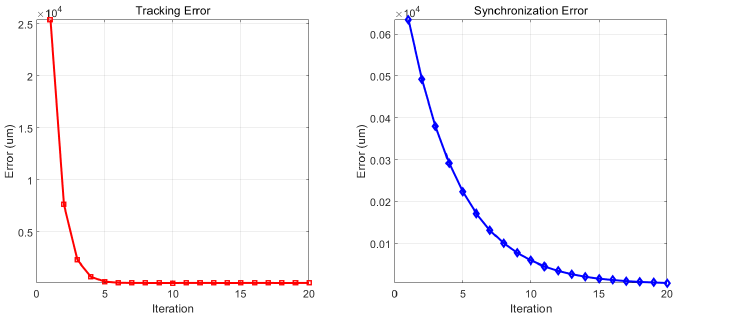
Figure 13. Tracking and synchronization